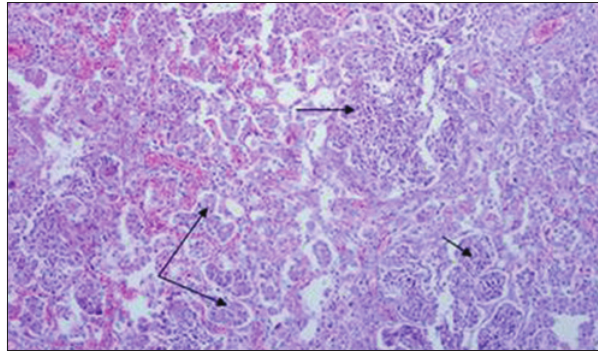
Figure-3: Lungs of ovine pulmonary adenocarcinoma polymerase chain reaction positive sheep showing proliferative changes in alveolar epithelial cells forming papillomatous projections into the alveoli (arrow) (H and E, 100×).